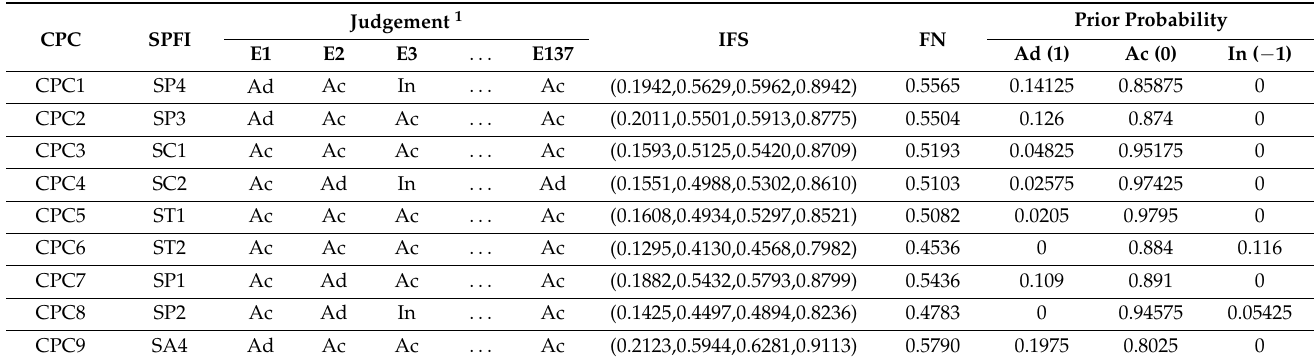
Table 9. The prior probabilities of the common performance condition indicators (CPCs).